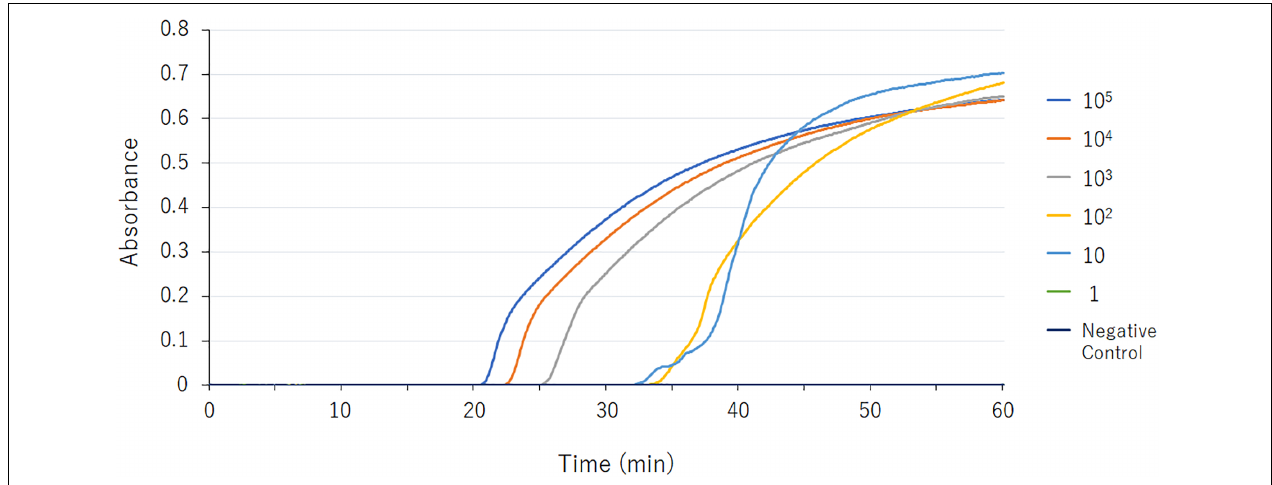
FIGURE 1 | bla GES LAMP assay data derived via real-time turbidimetry. Serial 10-fold-diluted samples (10 5 , 10 4 , 10 3 , 10 2 , 10, and 1 DNA copies) were assayed by LAMP. The detection limit was 10 DNA copies.